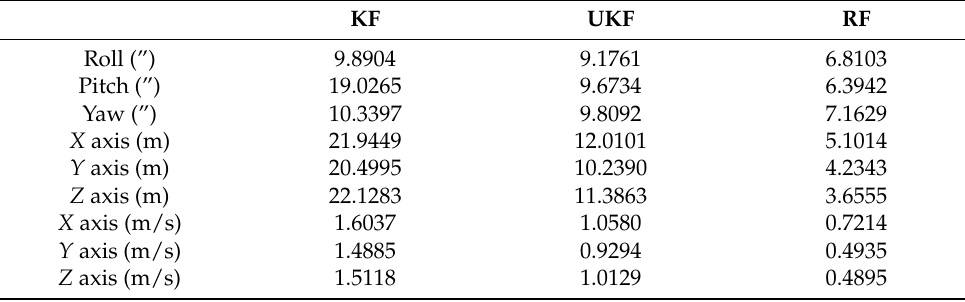
Table 4. Root mean square error data estimated by three algorithms (Condition